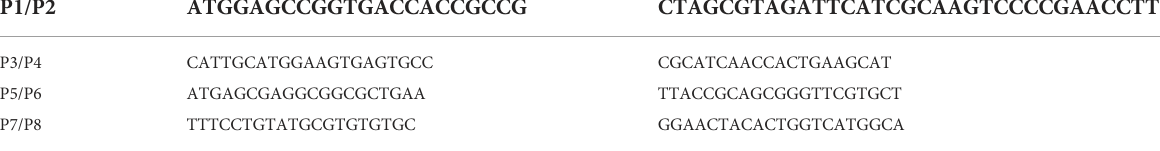
TABLE 2 Primers used for PCR diagnostics of LmX.11.1240 and LmX.34.0320